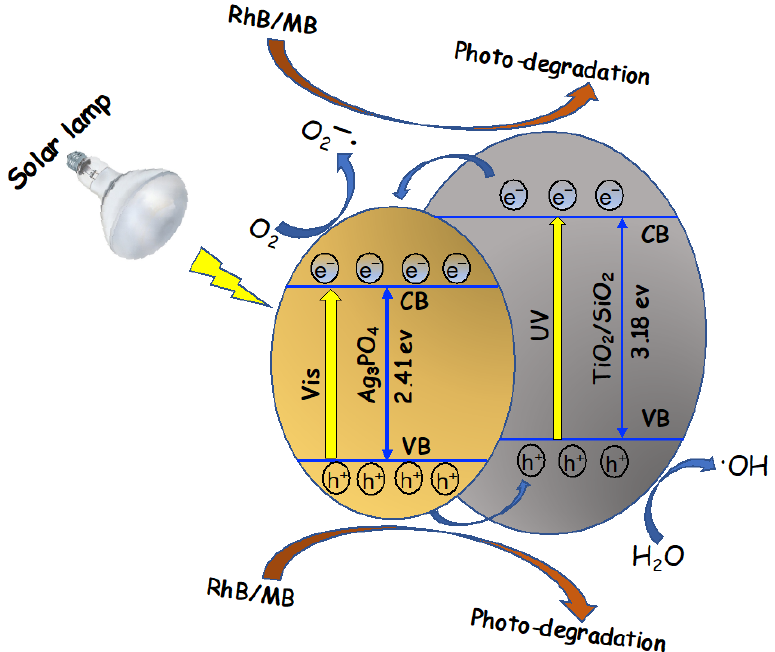
Figure 6. Schematic representation of the enhanced photodegradation mechanism of